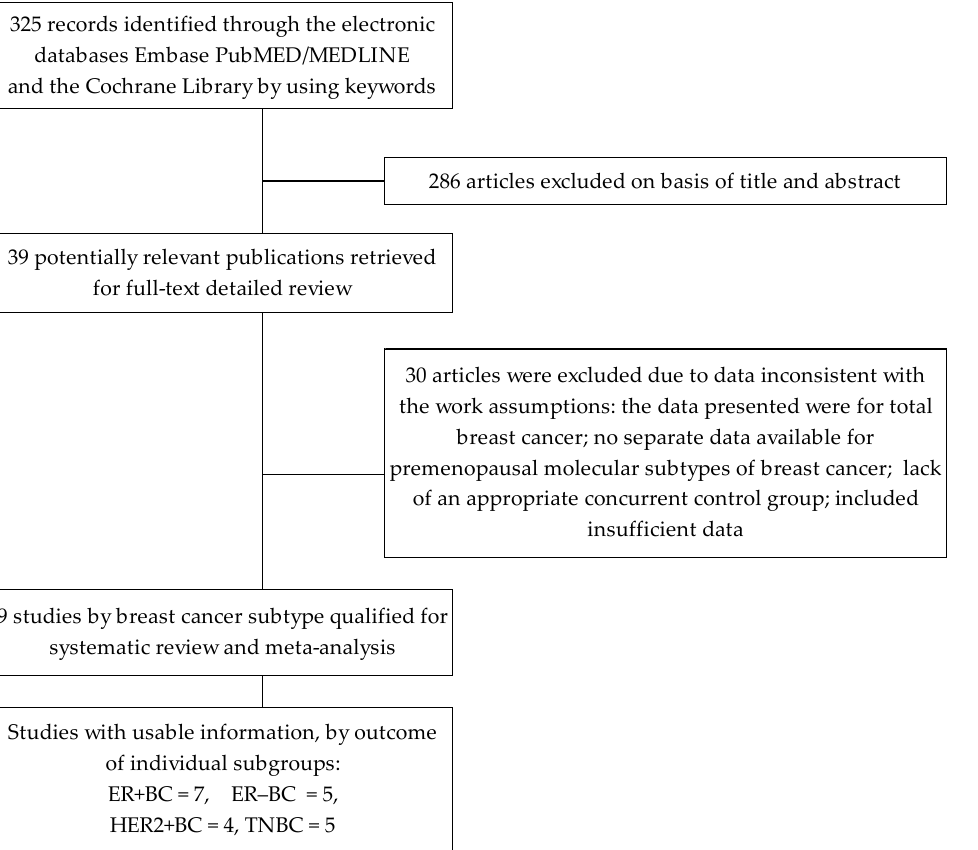
Table 1. Characteristics of included